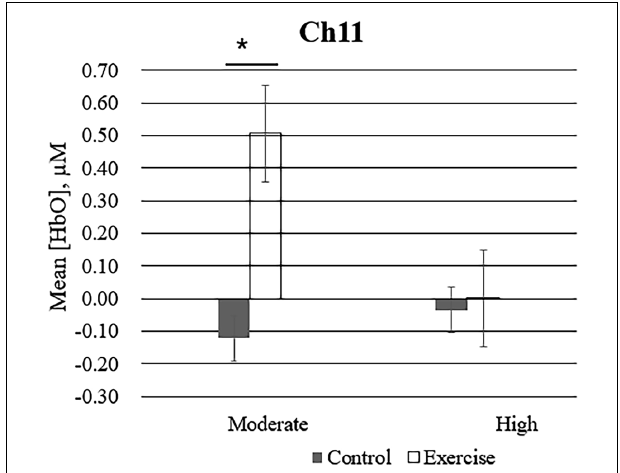
FIGURE 4 | Mean changes in oxyhemoglobin concentration (HbO) for channel 11 (Ch11) as participants in the exercise and control groups view images of high-calorie foods grouped by exercise intensity. Bars represent participant means, and vertical lines represent standard errors of the mean; ∗ P = 0.02.